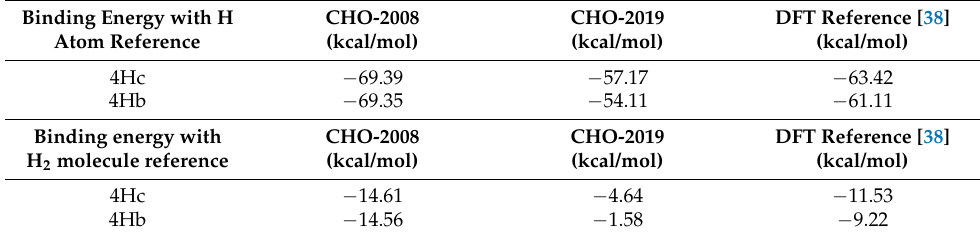
Table 2. Double-sided hydrogenation energies for different configurations.